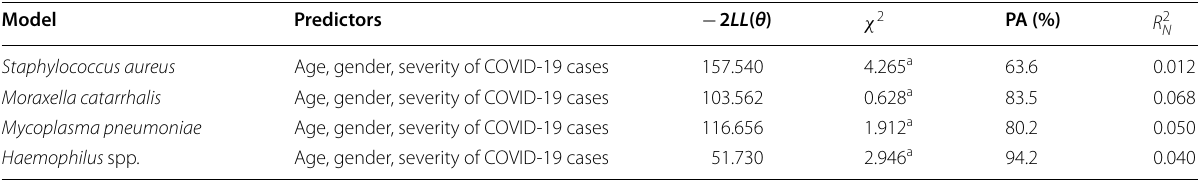
Table 5 Fitted binary logistic regression of bacterial infection associated with COVID‑19 severity